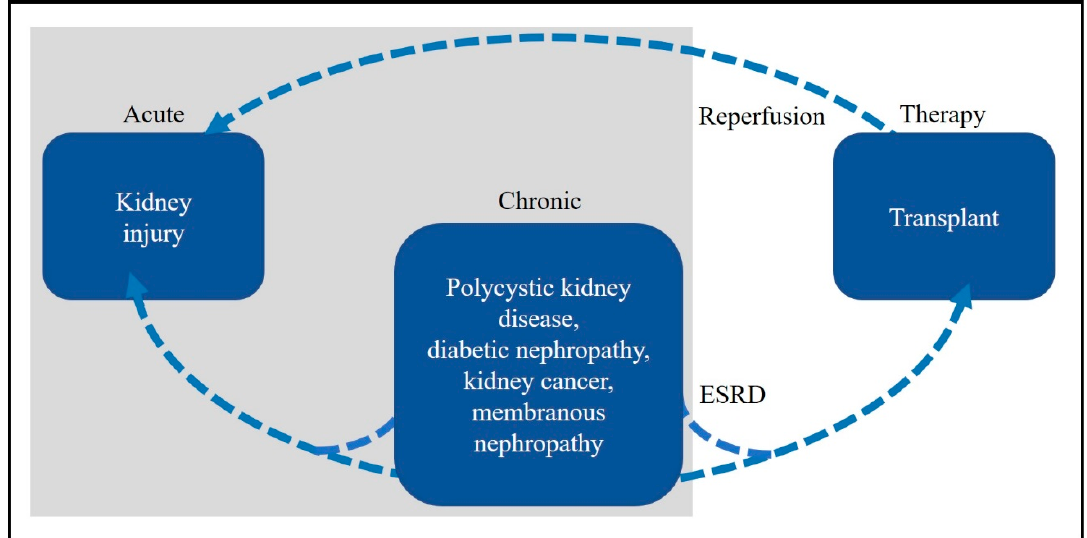
Figure 1. The overlapping relationships of the described kidney diseases. Chronic kidney disease and sub-entities: Polycystic kidney disease, diabetic nephropathy, kidney cancer and membranous nephropathy may progress to end-stage renal disease requiring transplantation. Reperfusion after transplantation may result in acute kidney injury. Acute kidney injury may also result from sub-entities of CKD.